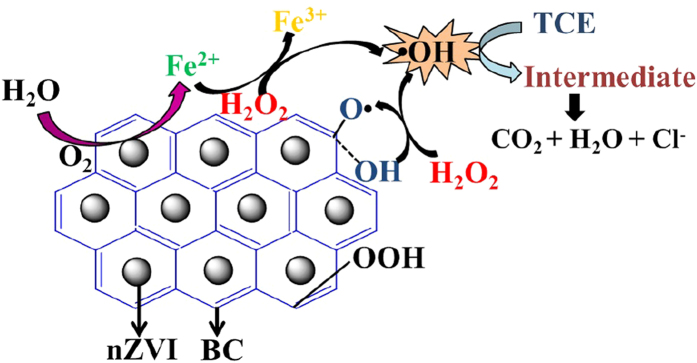
A proposed mechanism for TCE degradation by the nZVI/BC activation of H2O2.